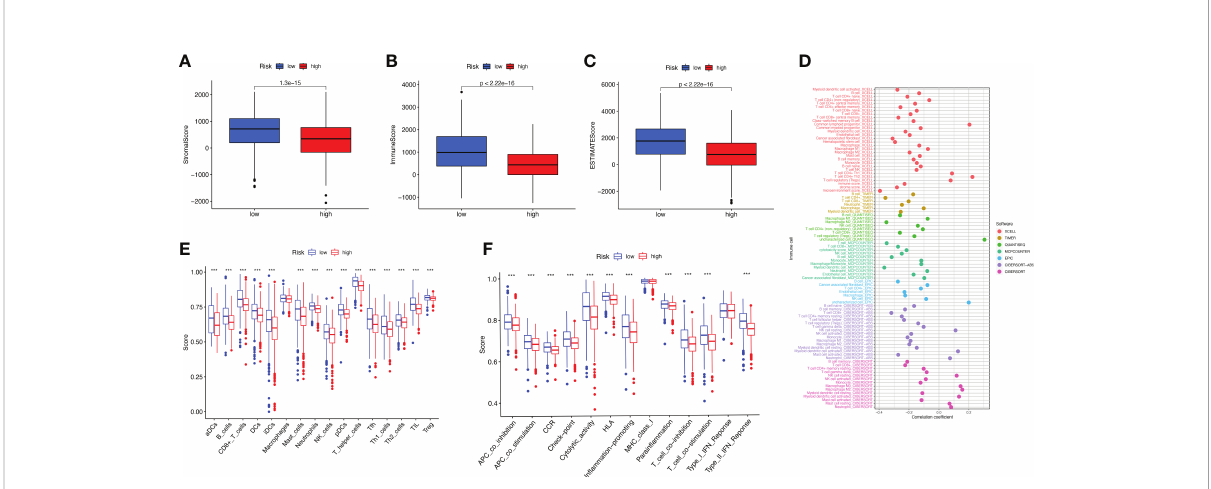
FIGURE 6 Study of BC immune status. (A – C) Box plots of StromalScore (A) , ImmuneScore (B) , and ESTIMATEScore (C) for high- and low-risk groups of BC patients. (D) Multiple algorithms to analyze immune in fi ltrating cells in BC. (E, F) Immune in fi ltrating cells (E) and immune-related function (F) scores for high- and low-risk